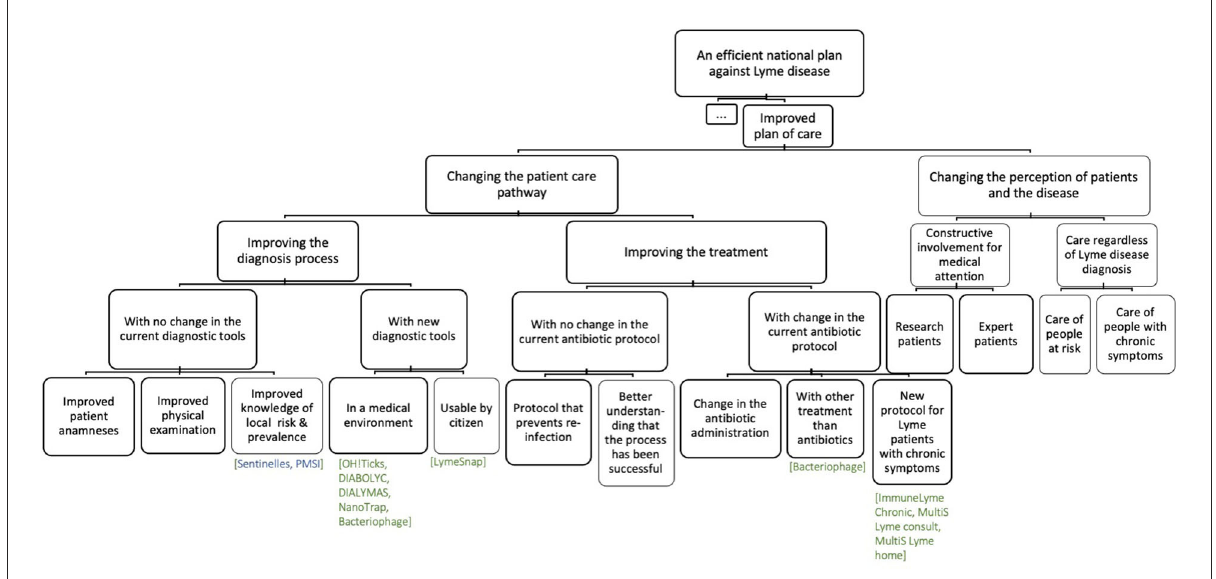
FIGURE6 The concept parts of the “improved plan of care” partition of CKf. In green, the names of the identified projects listed in Supp. Mat. 2. In blue, the name of networks or products in